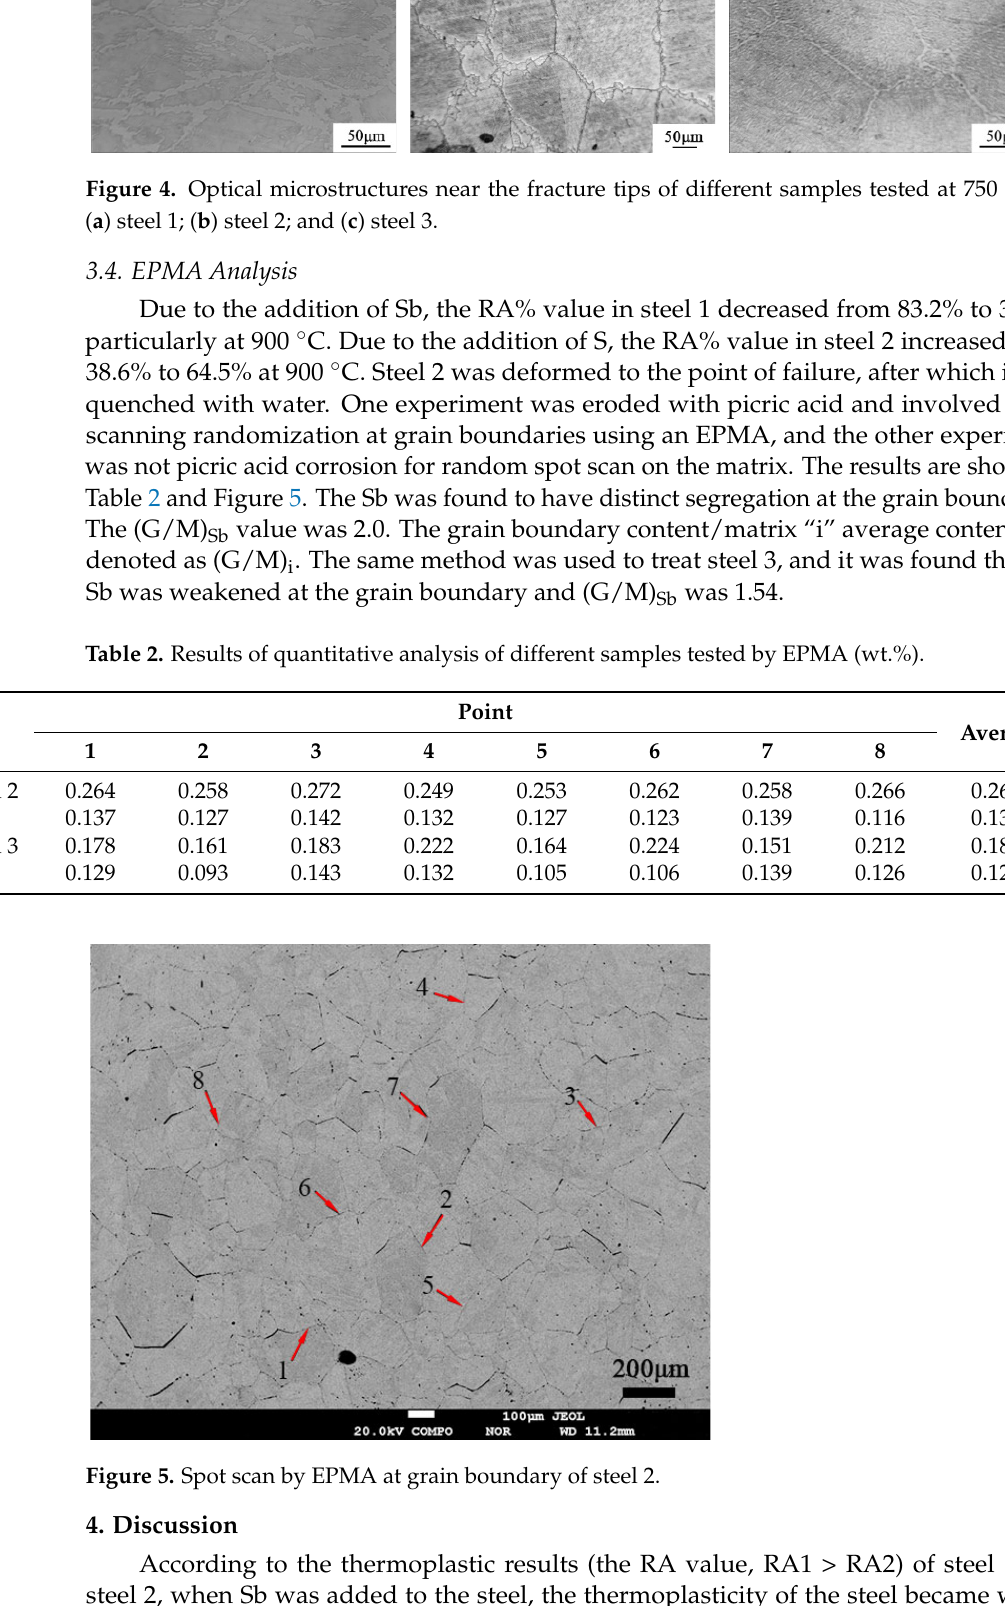
Figure 4. Optical microstructures near the fracture tips of different samples tested at 750 °C for ( a ) steel 1; ( b ) steel 2; and ( c ) steel 3.